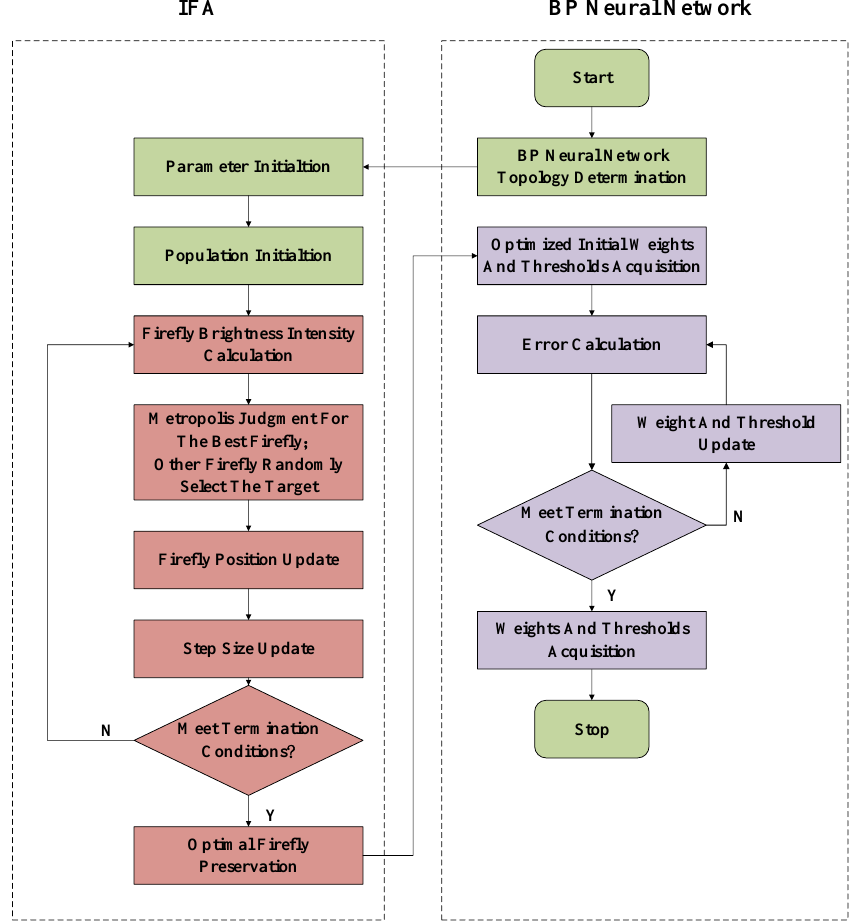
Figure 5. Flow chart of the IFA-BP neural network.